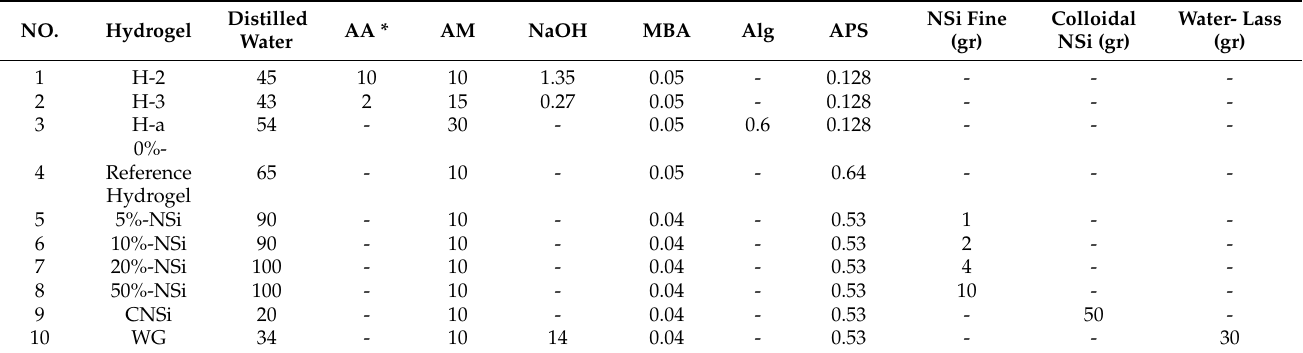
Table 1. NSi content